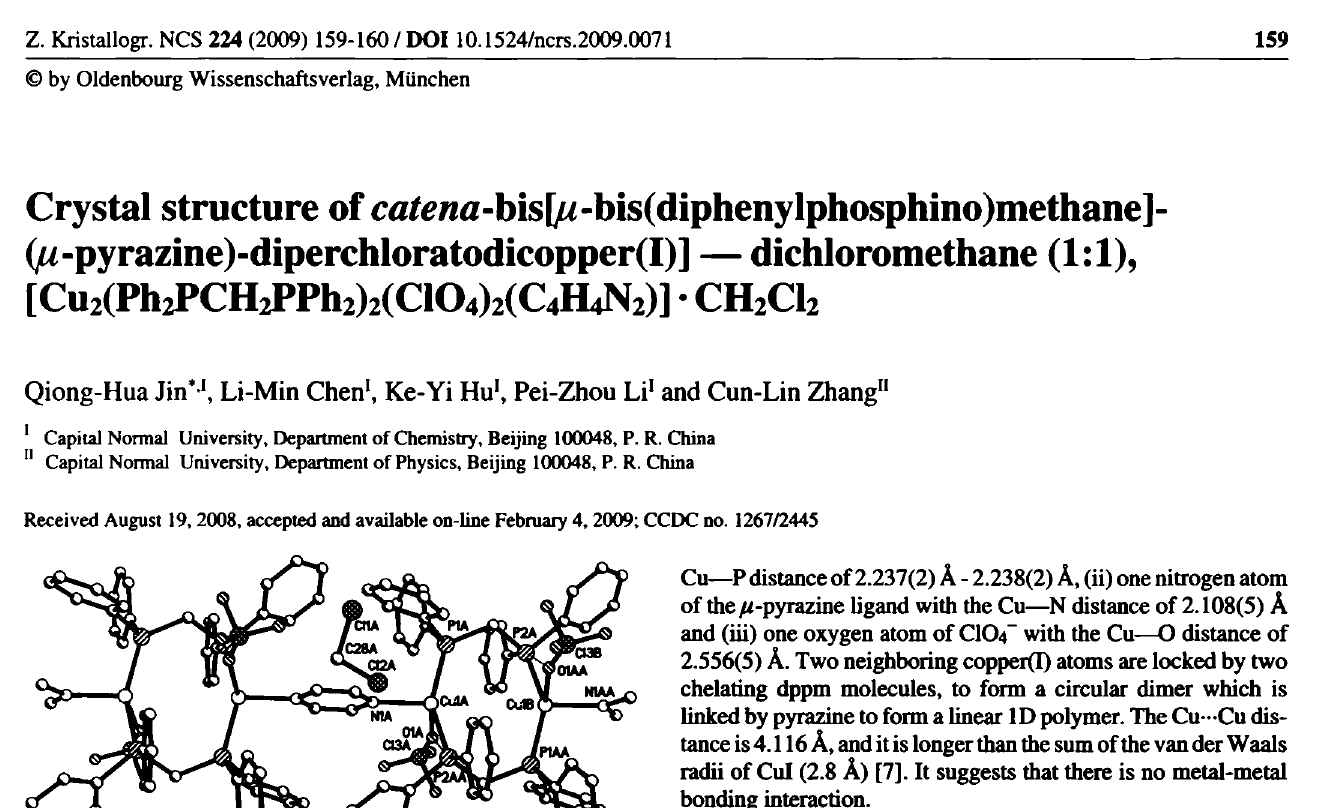
Table 1. Data collection and handling.